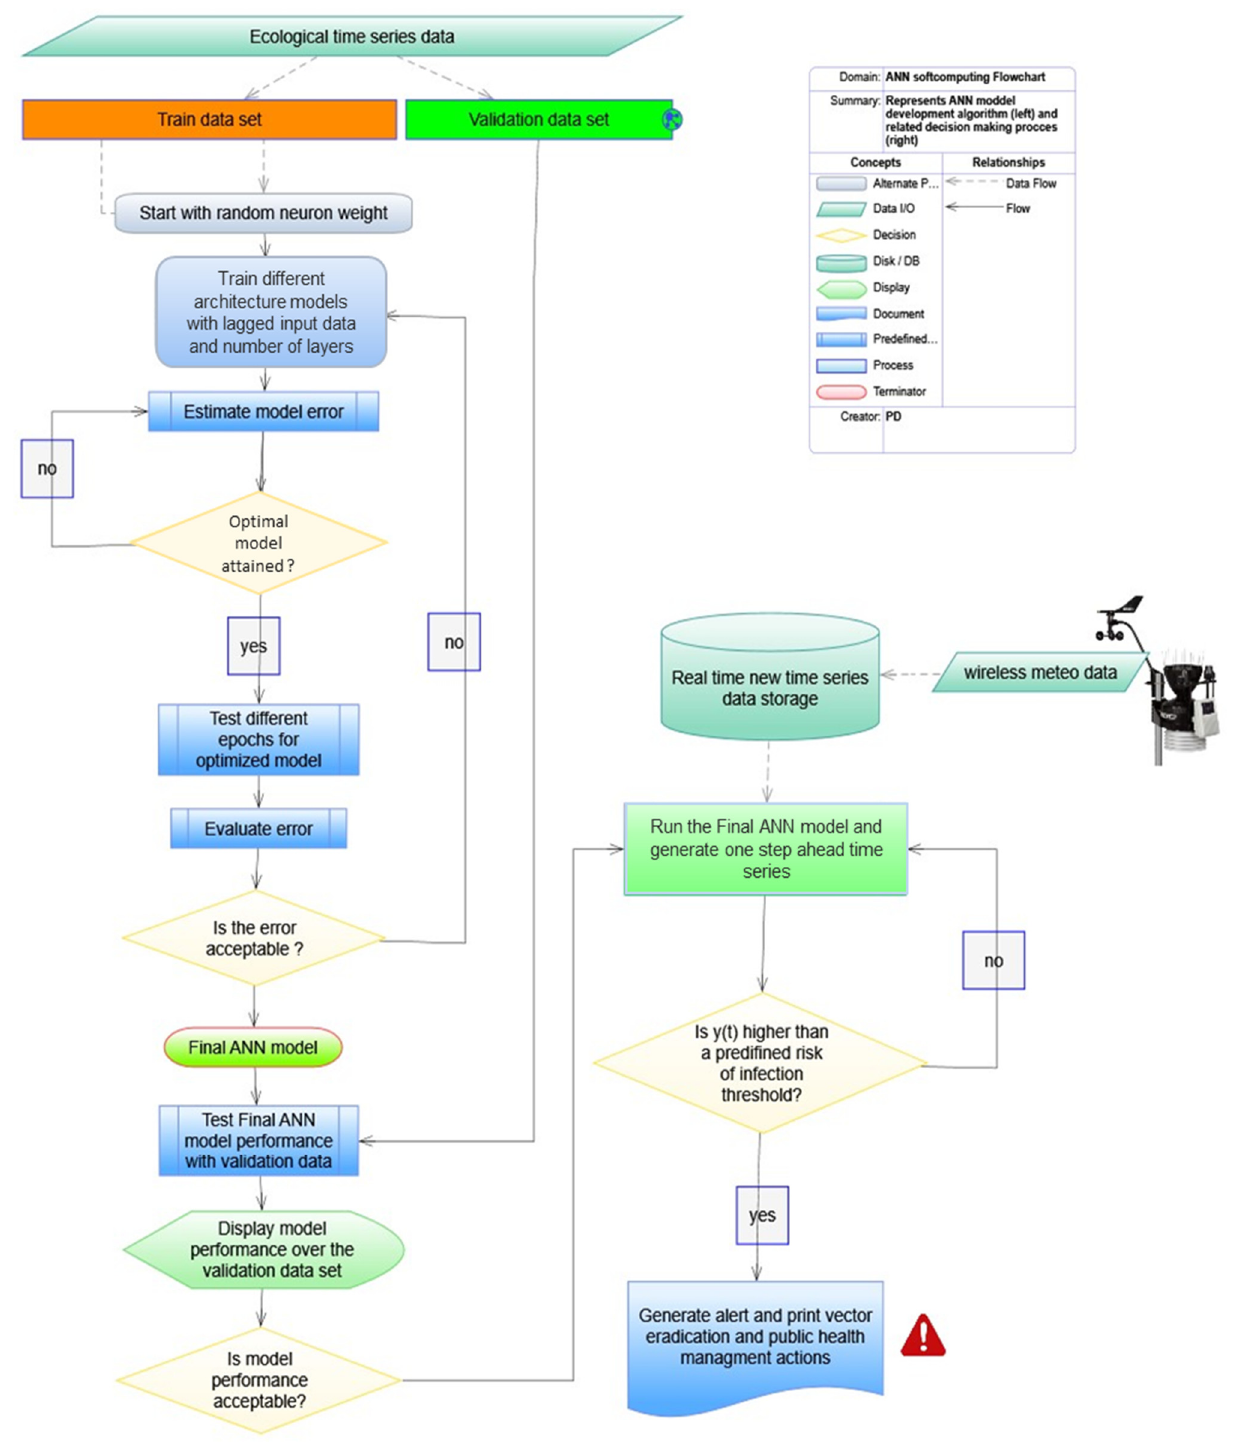
Figure 8. Graphical illustration of the logical operations followed to develop the dynamics autoregressive ANNs models for predicting adult mosquito population dynamics ( left ). Real-time data can be used later to forecast the arthropod vector population dynamics based on the calibrated ANN model that has been developed or to be retrained under new circumstances ( right ).